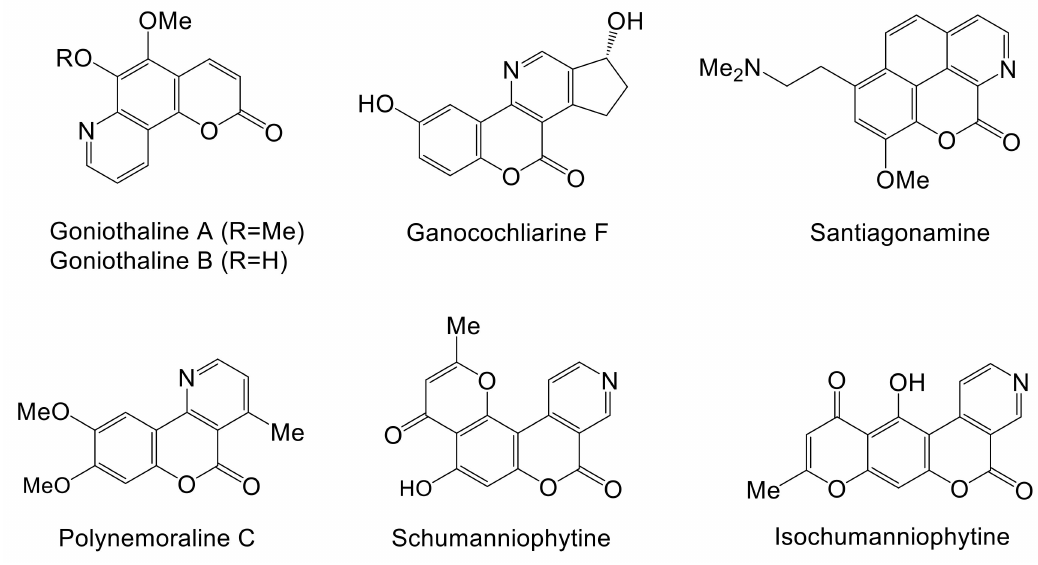
Figure 1. Representative fused pyridocoumarins found in